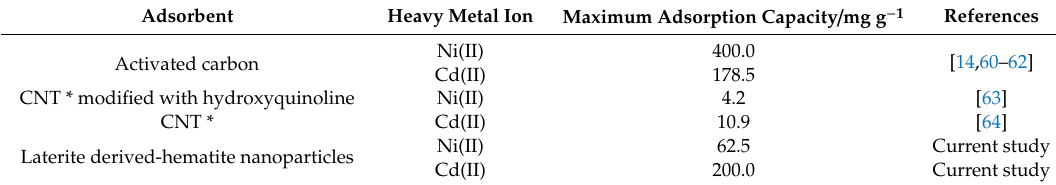
Table 8. Comparison of Cd 2 + and Ni 2 + ions adsorbents and their maximum adsorption capacities